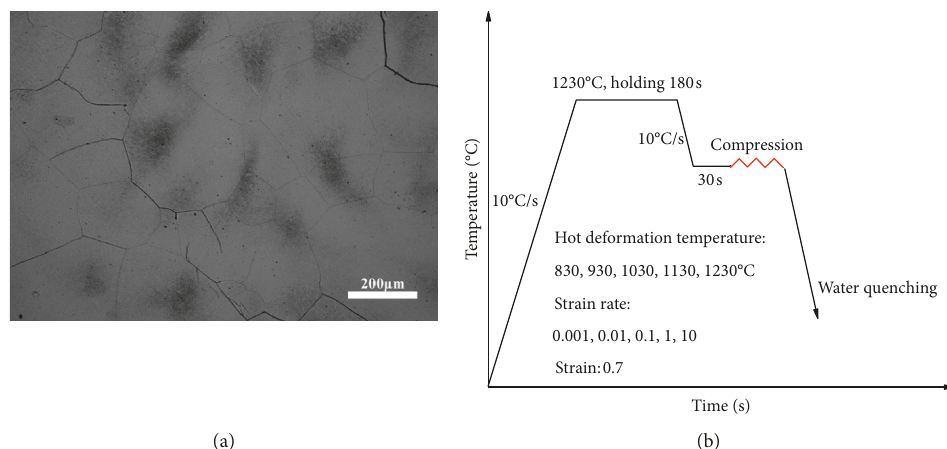
Figure 1: (a) The prior austenite grains of as-received 5CrNiMoV steel. (b) Schematic diagram of hot compression